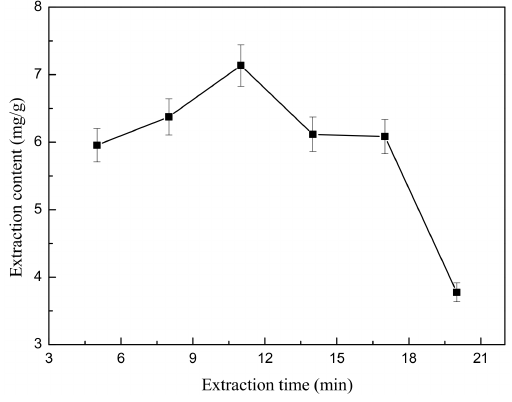
Figure 7. Effect of different treatment times on ultrasonic